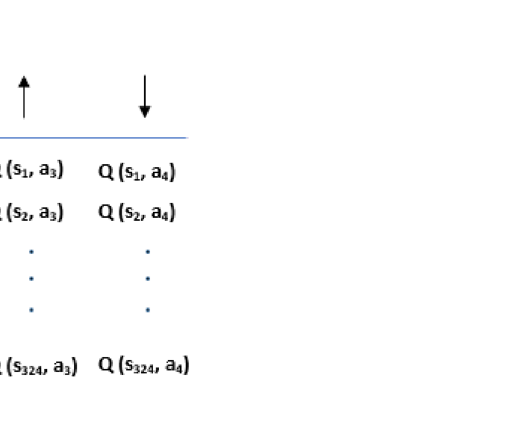
Figure 9. The Q-table with 324 states and 4